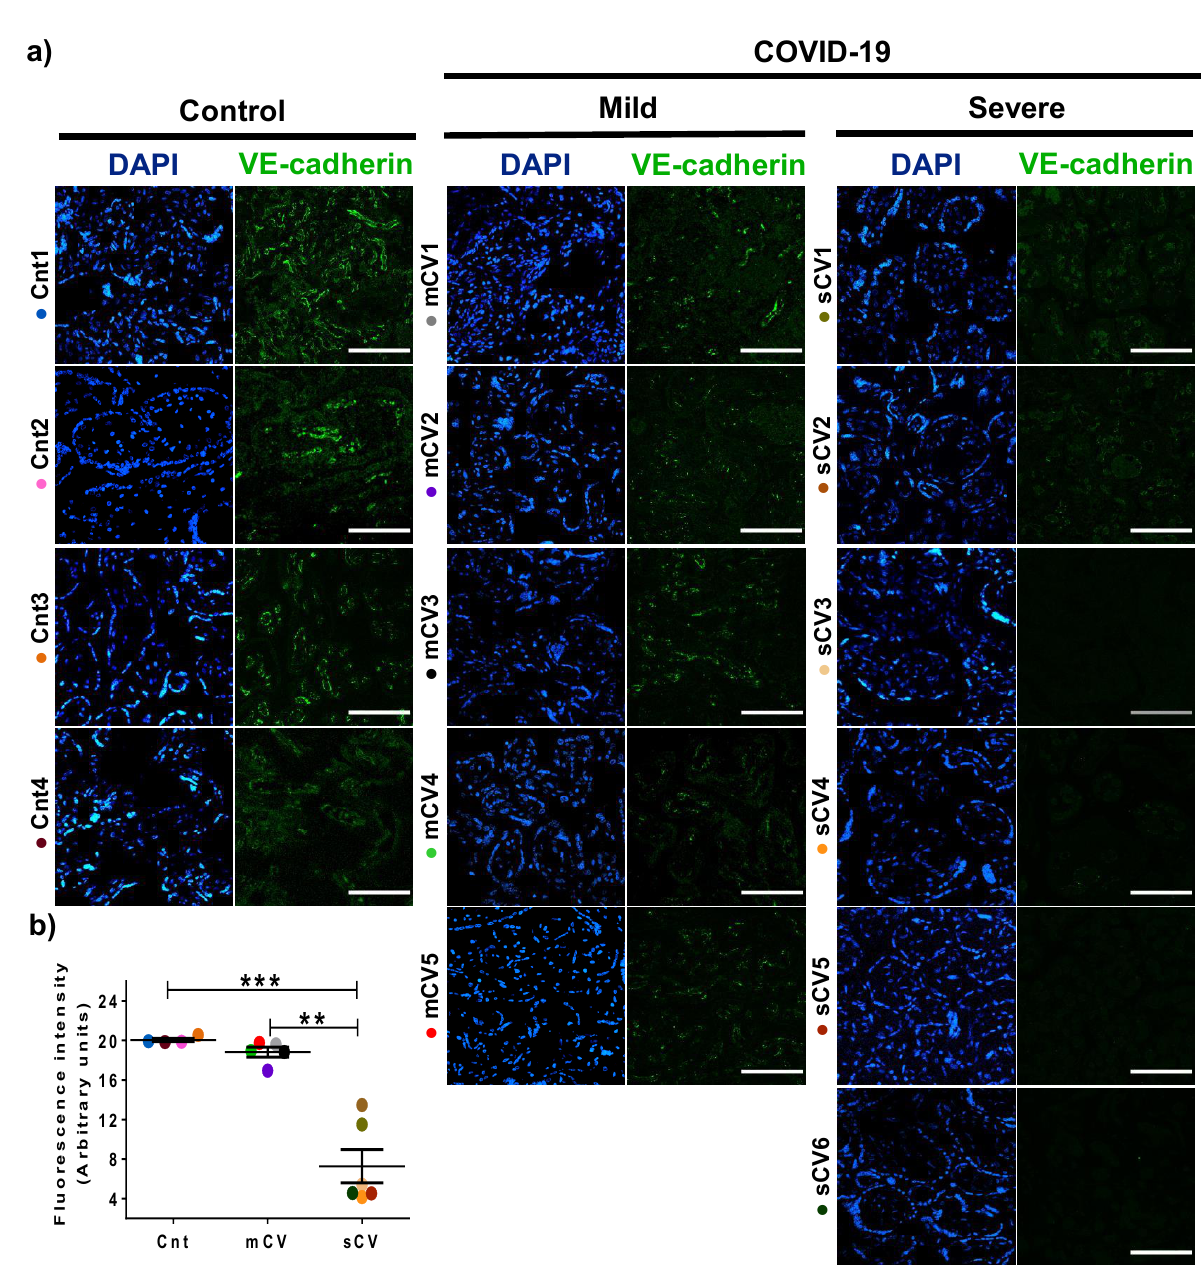
Figure 6. VE-cadherin expression diminishes in the endothelium of chorionic villi of placentas from women with severe COVID-19. Paraffin blocks of placentas derived from women with COVID-19 and controls were cut in 1 µm slices, deparaffinized, and processed for immunofluorescence with antibodies against VE-cadherin. ( a ) Representative images of VE-cadherin in chorionic villi. DNA of nuclei was stained with DAPI. Bar, 100 μm. ( b ) Quantification of mean fluorescent intensity done on three independent images from each condition. Data are expressed as median ± SD; Kruskal–Wallis test and its multiple comparison test, ** p = 0.02, *** p < 0.001. Cnt, control; mCV, mild COVID-19; sCV, severe COVID-19.